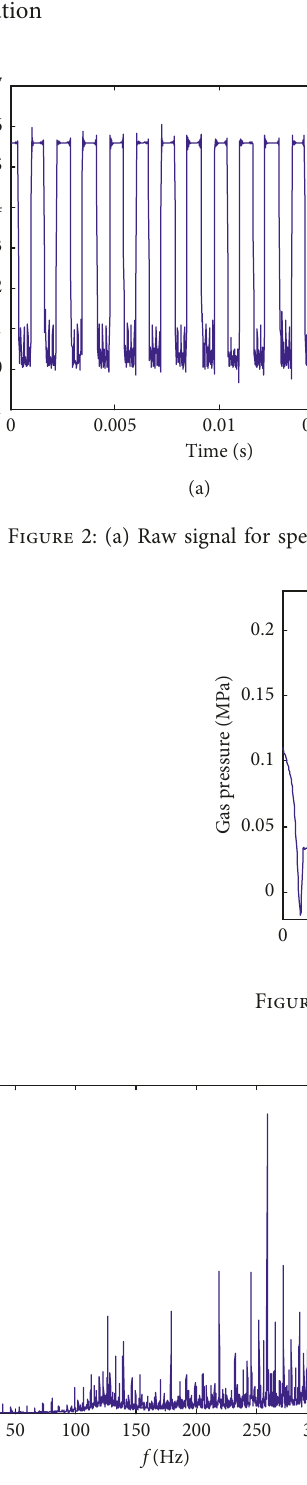
Figure 4: Vibration of the cylinder